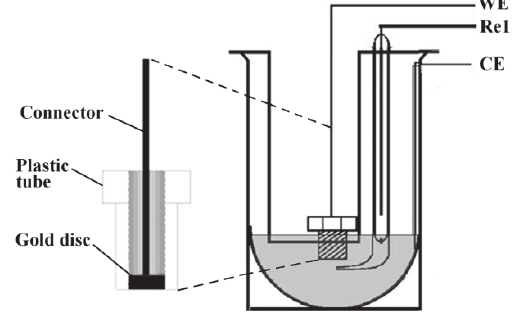
Fig.1: Three-electrode cell. WE: working electrode, Re1: reference electrode, CE: counter-electrode.